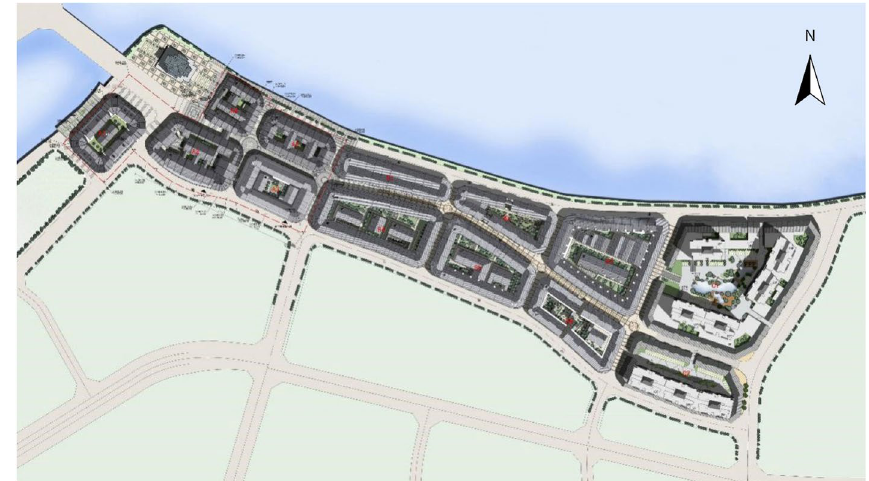
Fig. 4 The targeted area of the original plan for the Shuidong Reconstruction Project. (Source: Huizhou Municipal Bureau of Housing and Urban– Rural Development)